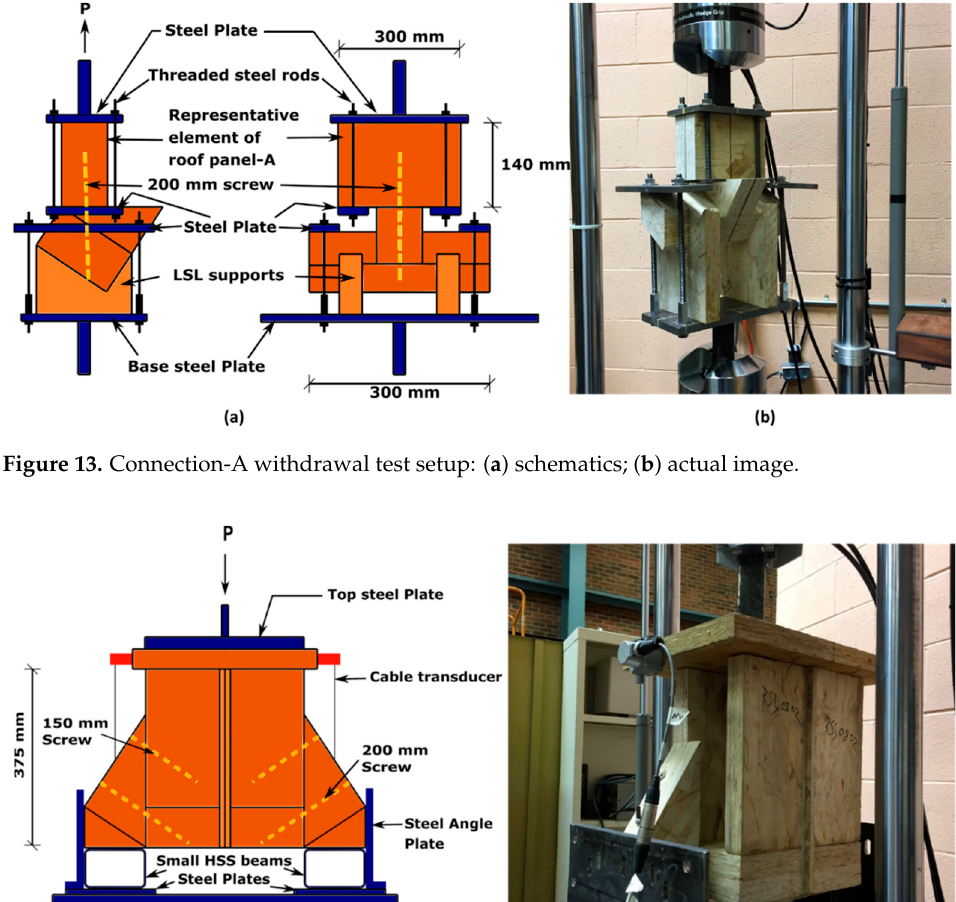
Figure 15. Schematics of Connection-C test setup: ( a ) loading parallel to strand; ( b ) perpendicular to strand.